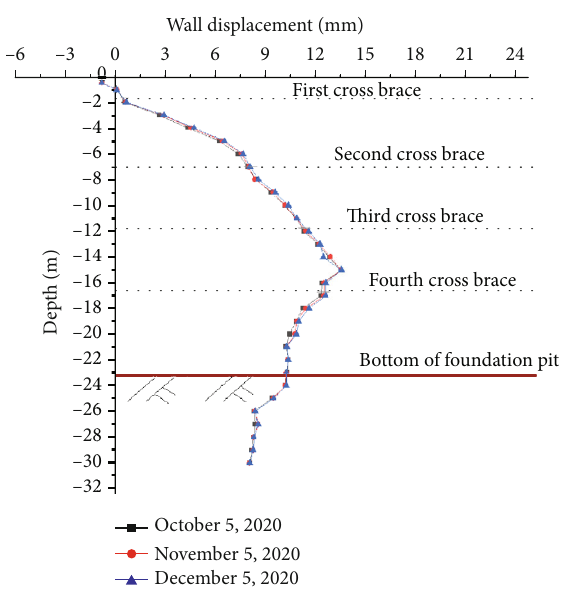
Figure 11: Horizontal displacement of underground diaphragm wall in typical